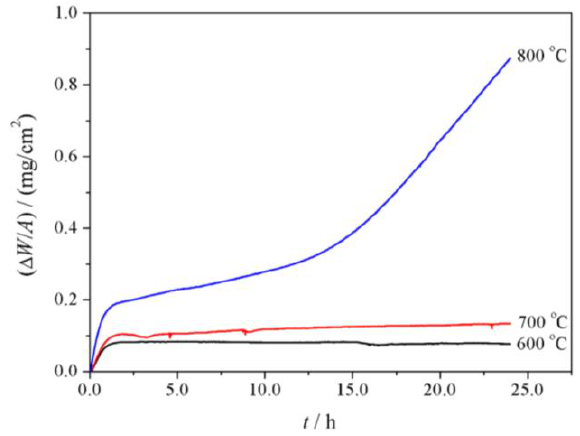
Figure 1. Oxidation kinetics of P92 steel in pure oxygen.